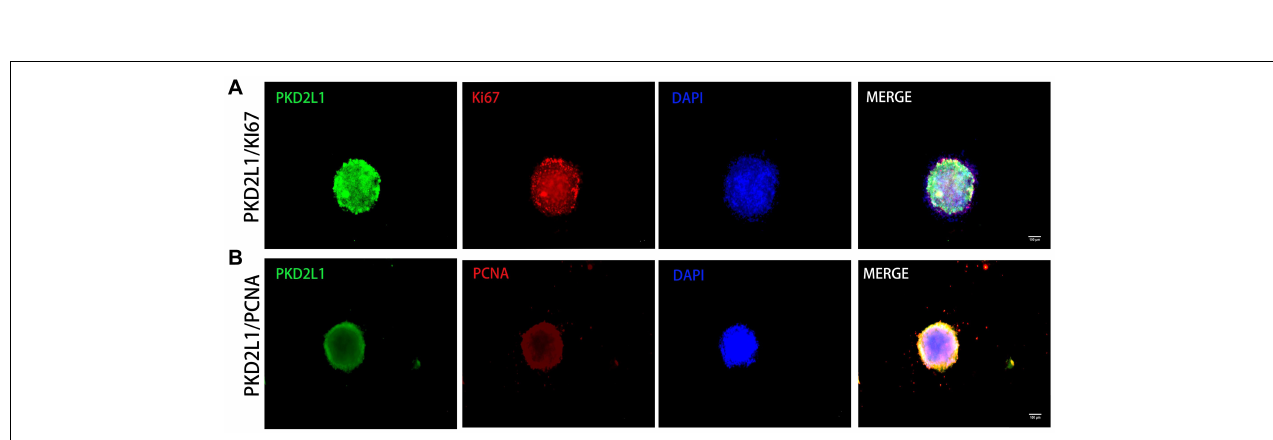
FIGURE 4 | Neurospheres formed by CSF-cNs exhibited the ability to proliferate. (A,B) Immunofluorescence analysis showing that neurospheres were able to proliferate and expressed both Ki67 (A) and PCNA (B) .